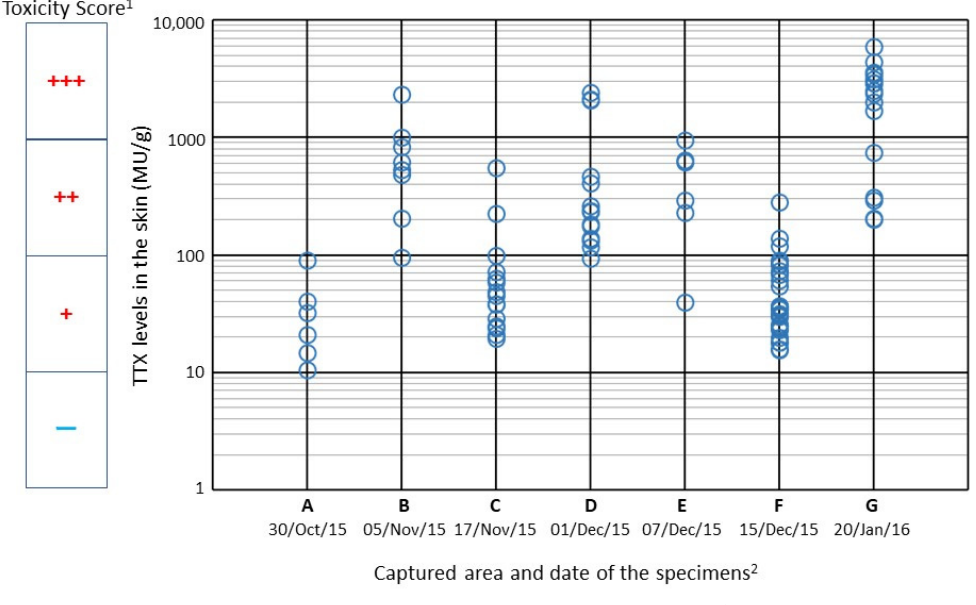
Figure 6. TTX levels in the skin of the pufferfish, Takifugu flavipterus . 1 Toxicity scores are +++: extremely toxic, ++: strongly toxic, +: moderately toxic, and − : nontoxic, as shown in Table 2. 2 The locations of the captured areas A to G are shown in Figure 2.